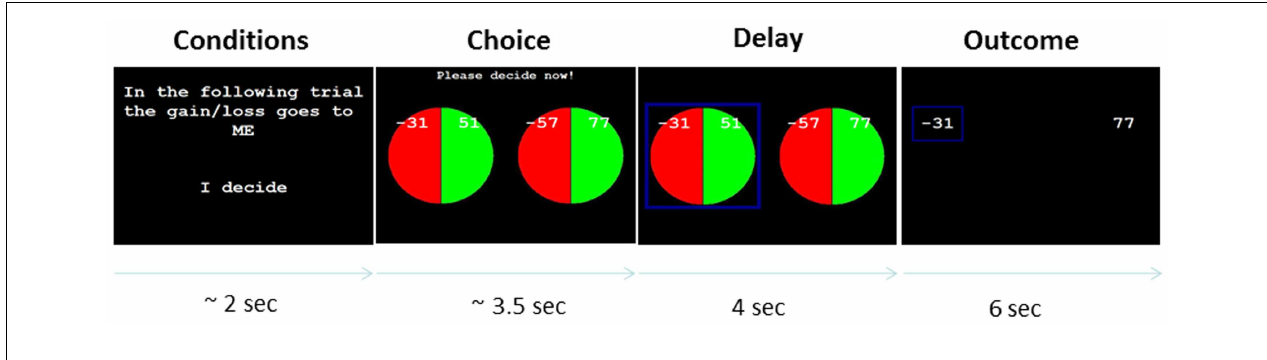
gain/loss of the chosen lottery would be assigned to the participant or to Anastasia (“self” vs. “other” condition), and whether the participant or the computer would decide which lottery would be played (“choose” vs. “follow” condition). See text, for detailed description of the